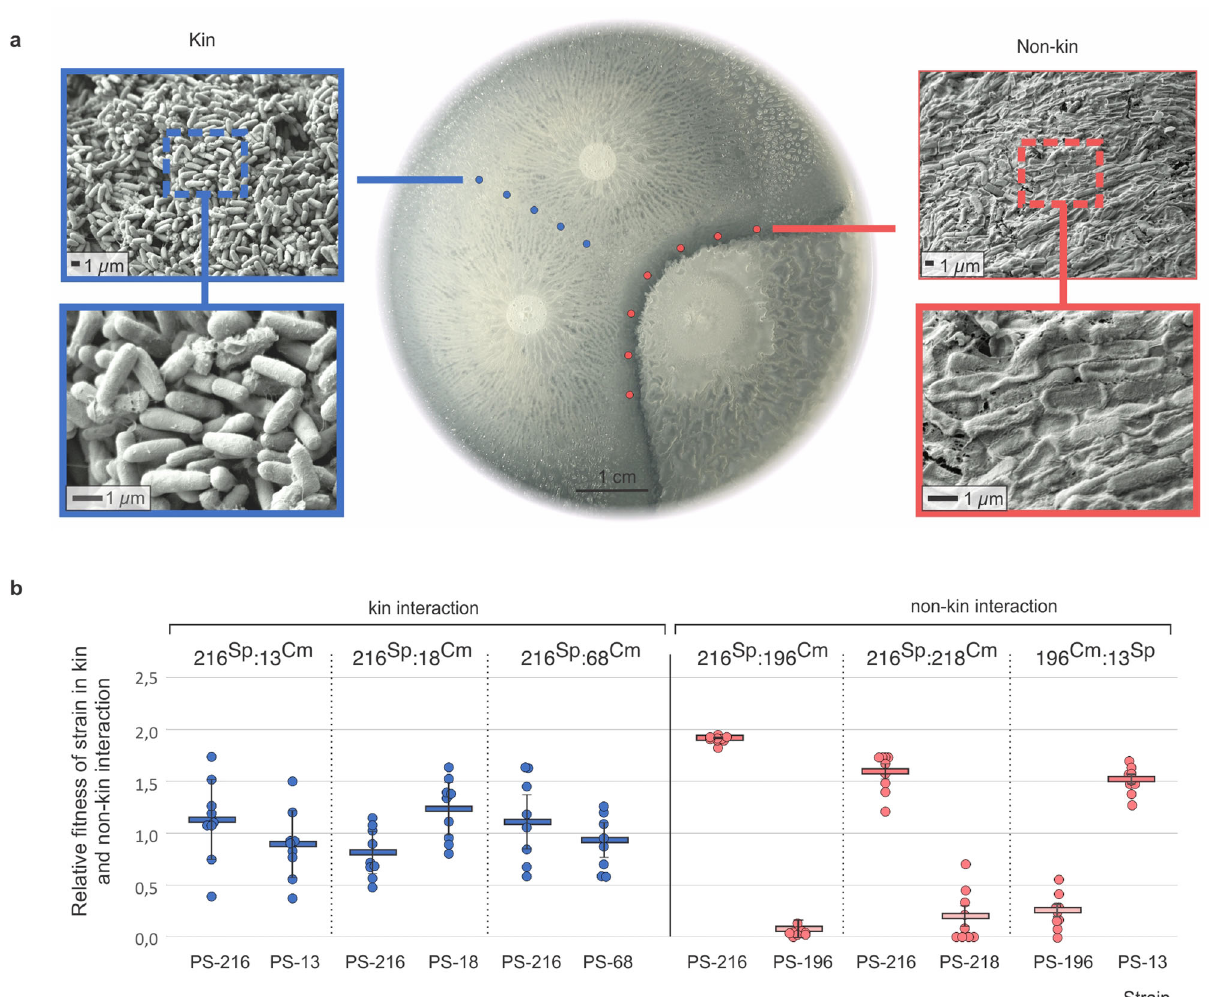
Fig. 3 Kin discrimination mediates fi tness via cell lysis. a Swarm assay on B agar. The left and right panels are scanning electron microscopy micrographs taken at the meeting point of kin strains PS-216 Sp and PS-13 Cm (blue, left) and non-kin strains PS-216 Sp and PS-196 Cm (red, right). b Relative fi tness of strains in kin pairings (blue) and non-kin pairings (red) ( n = 3 biologically independent experiments, each n performed in three technical replicates (9 data points)). See Table 2 for strain abbreviations. All experiments (in a and b ) were performed in three biologically independent experiments. Data are presented as mean values ±SD and error bars represent SD of the mean values ( n =